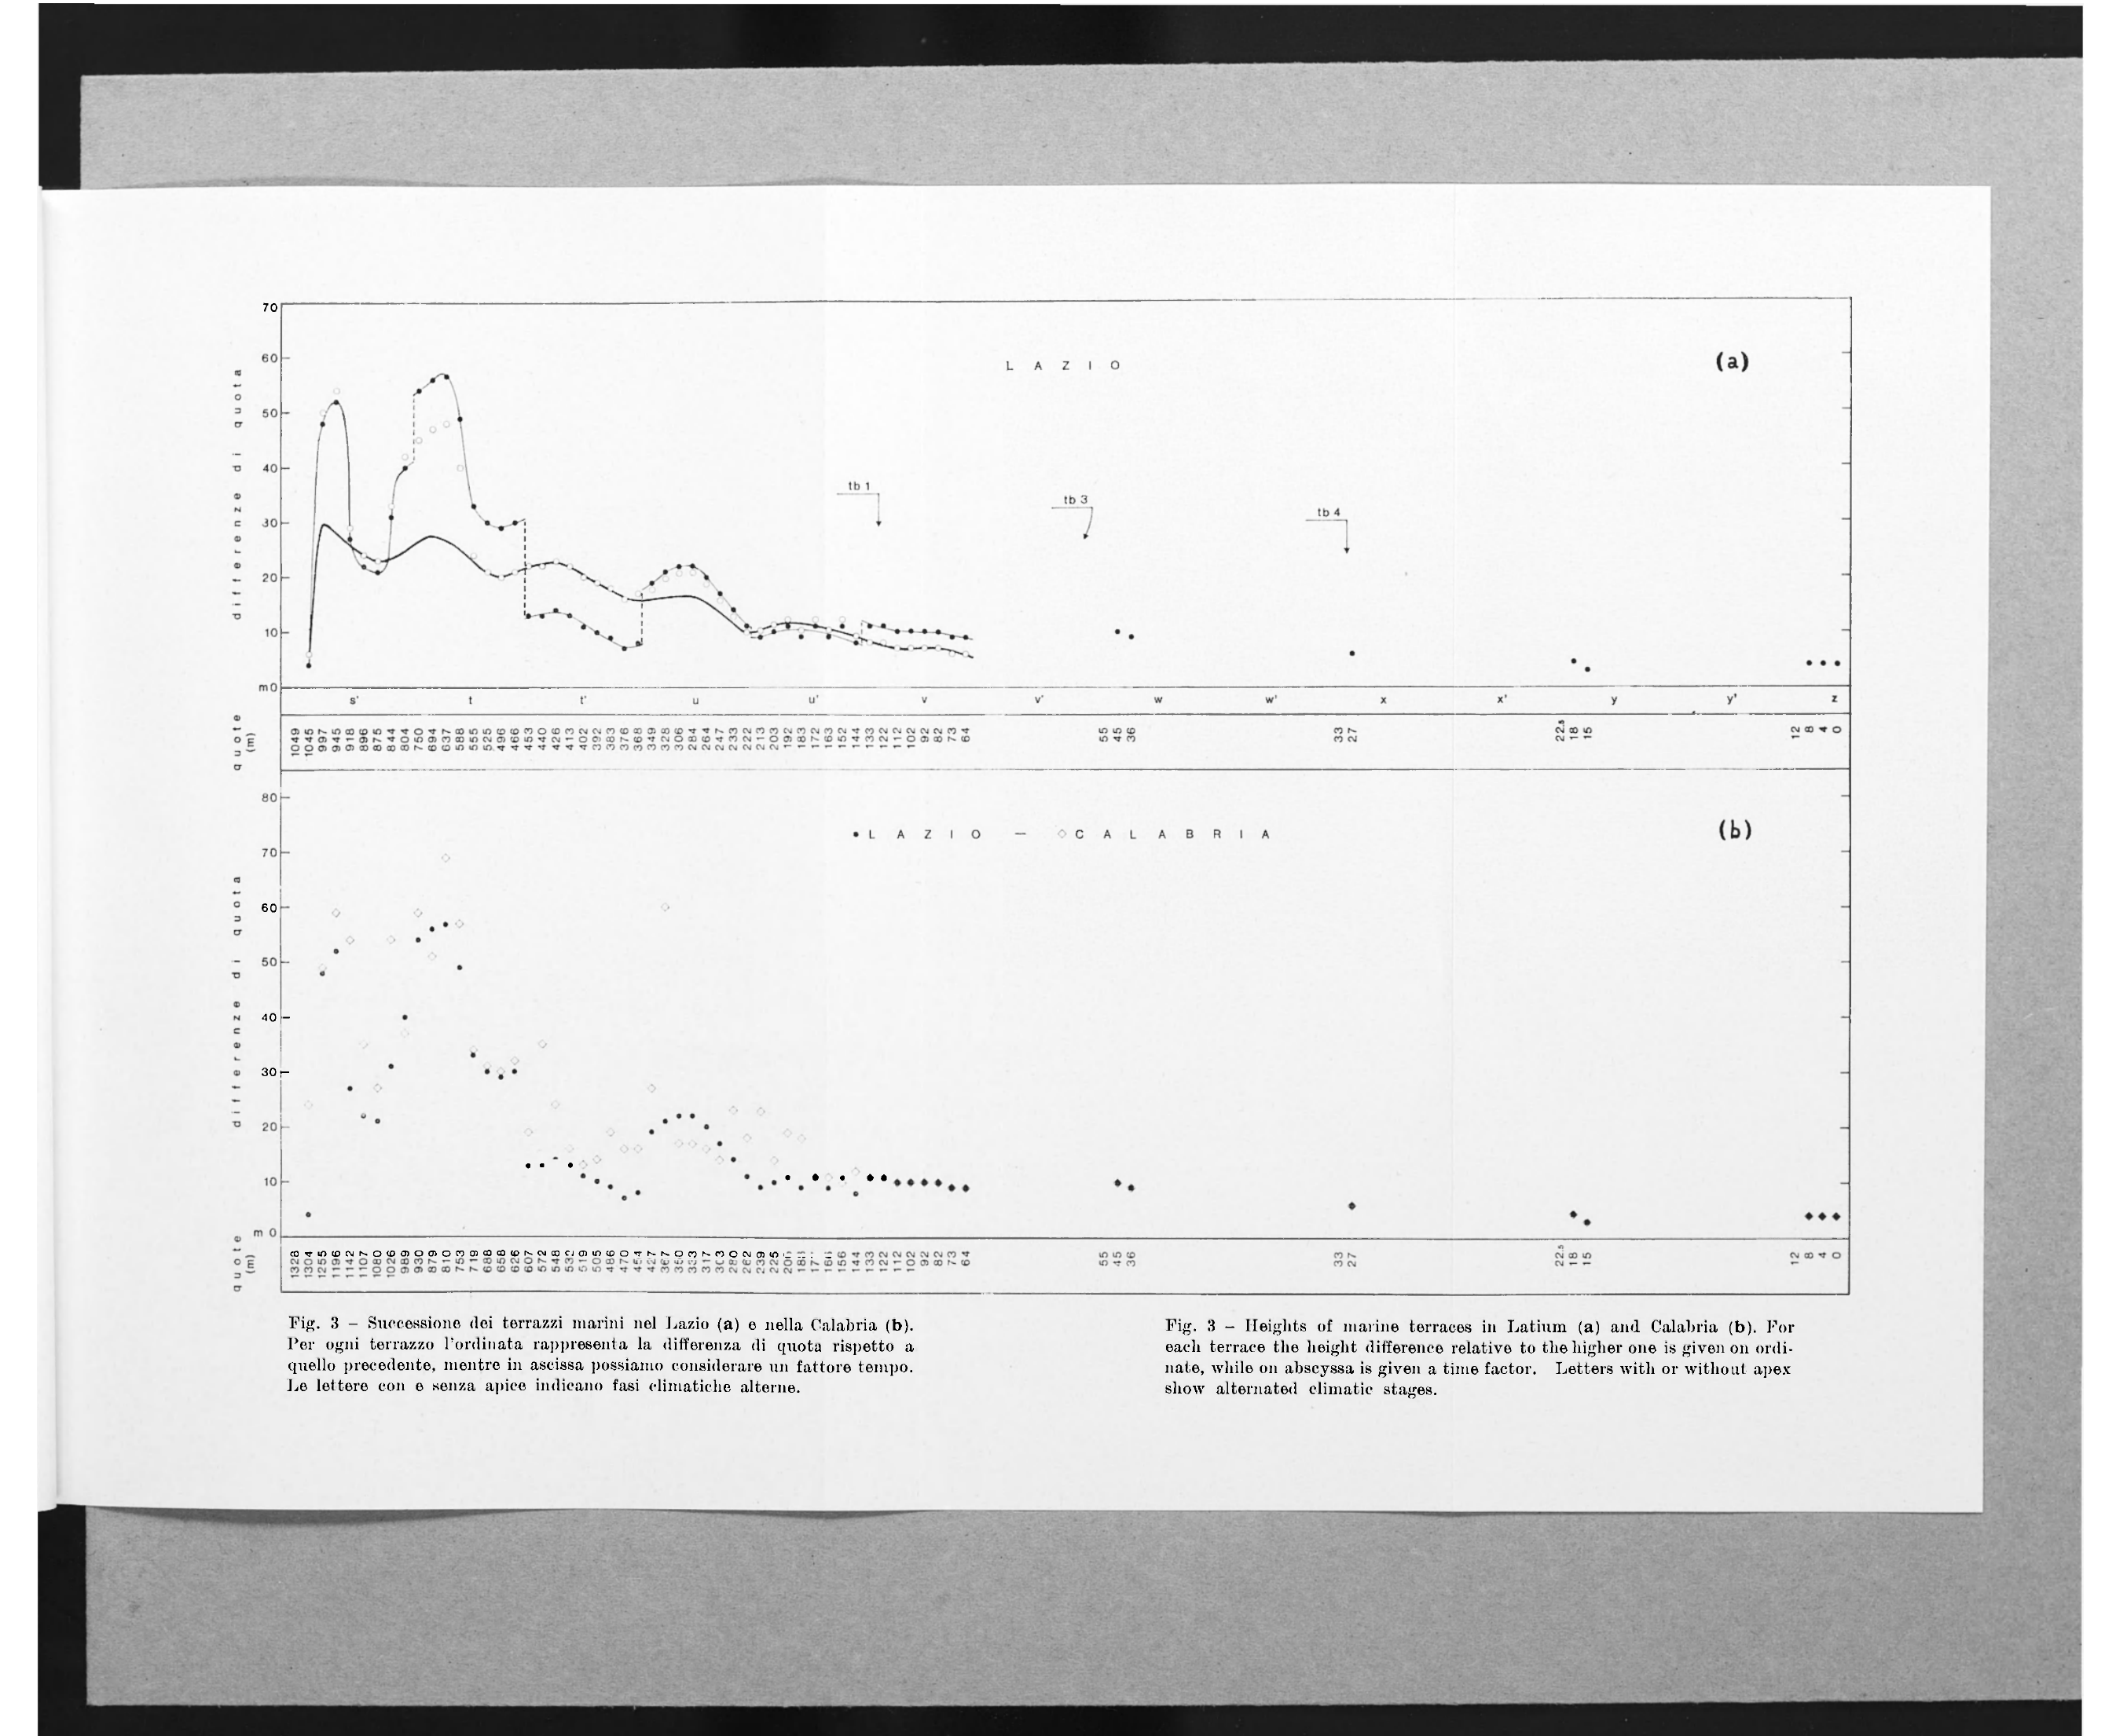
Pig. 3 - Heights of marine terraces in Latium (a) and Calabria (b). For each terrace the height difference relative to the higher one is given on ordi- nate, while on abscyssa is given a time factor. Letters with or without apex show alternated climatic